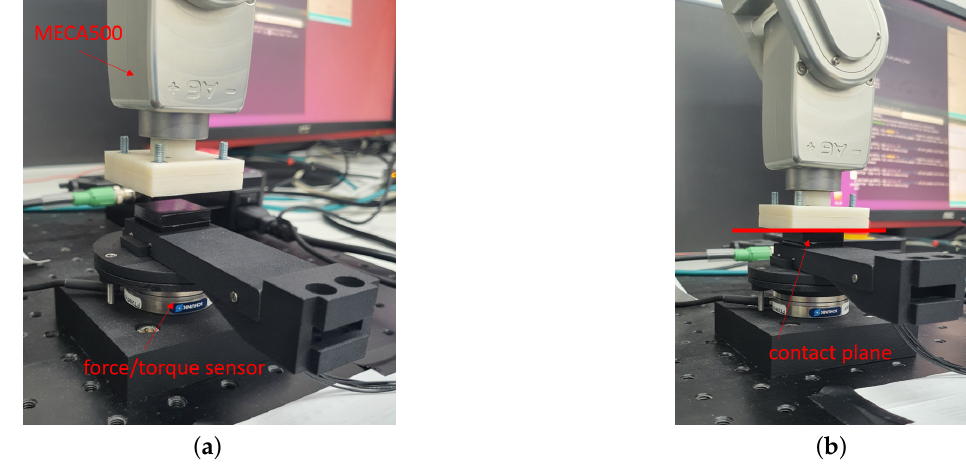
Figure 14. Experimental setup for the whole pad characterization: components ( a ) and contact example ( b ).